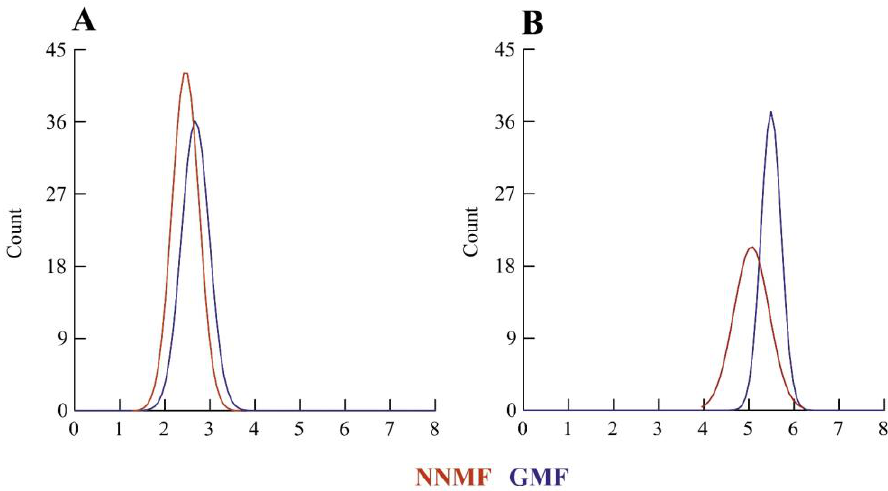
Figure 2. Morphometry of Lima bean chloroplasts in plants exposed to the GMF and NNMF. Density plots of minor axis length ( A ) and major axis length ( B ). X-axis values are expressed as